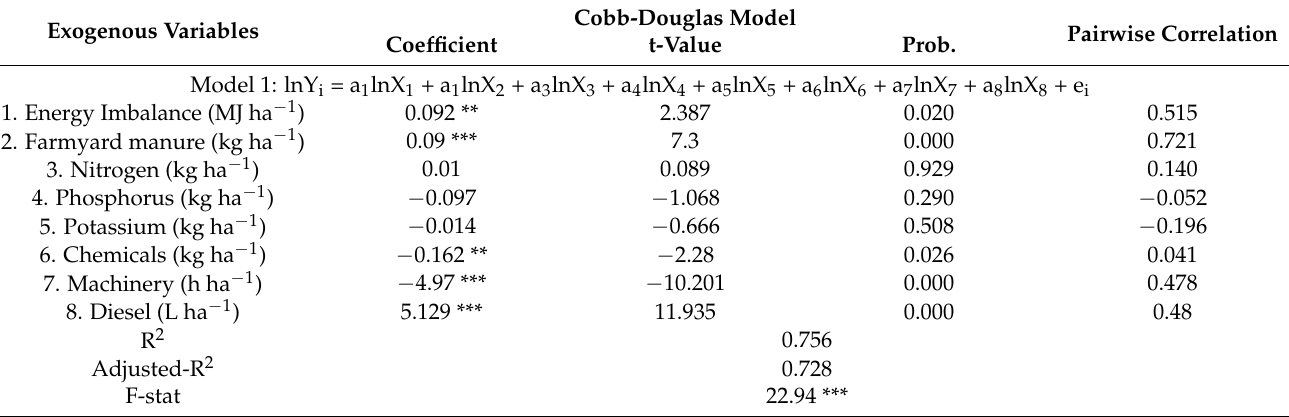
Pairwise Correlation